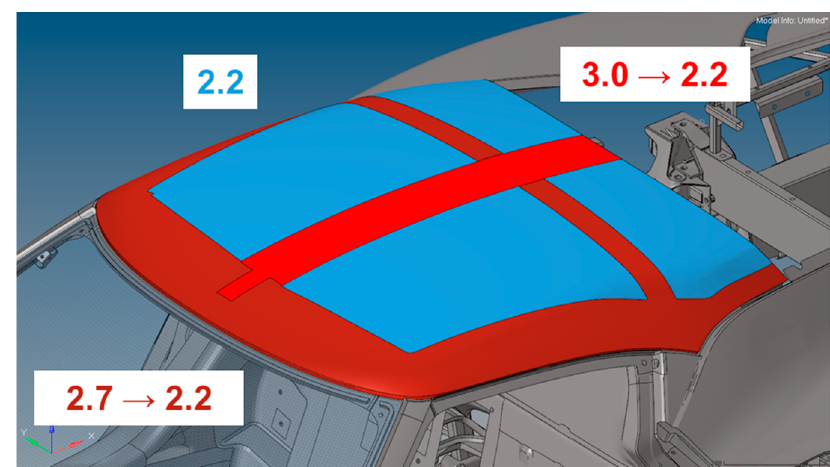
Figure 15. Pavilion thickness variation in the new optimized PP23CF configuration.